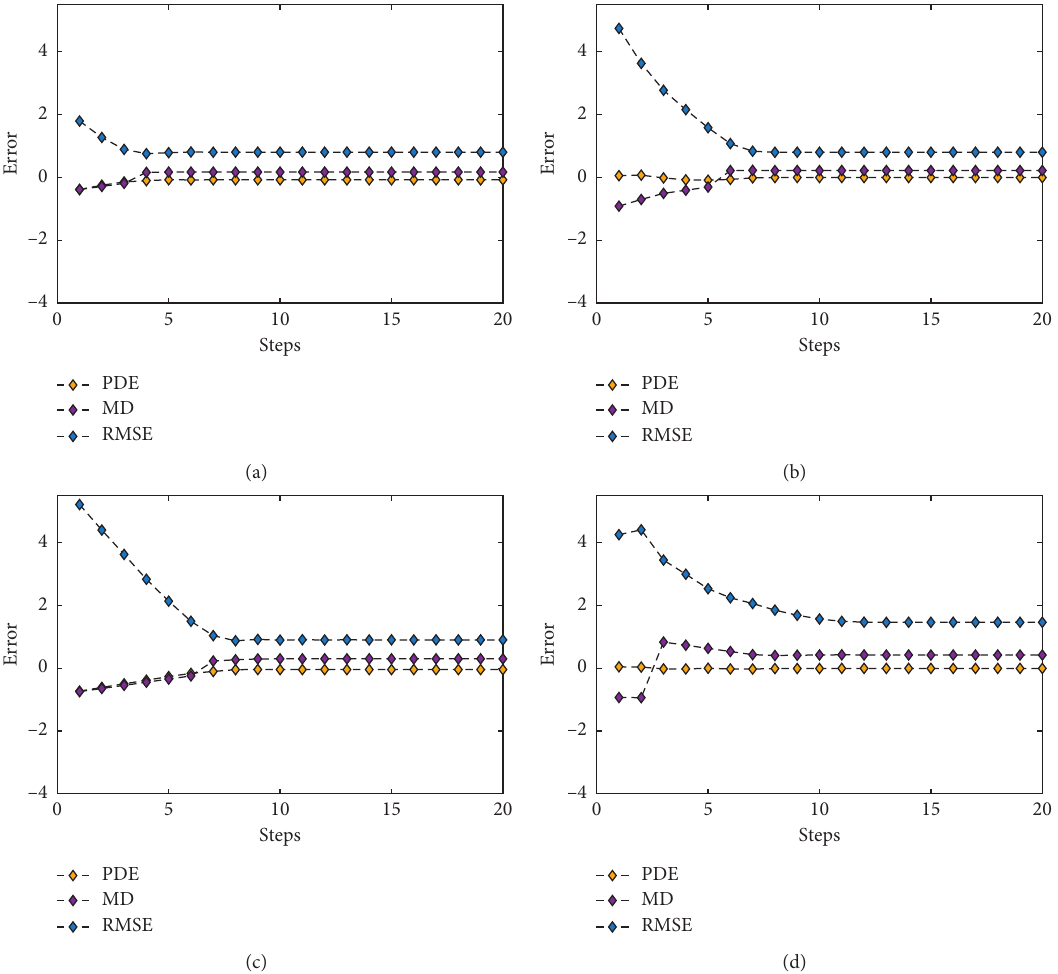
Figure 12: Error convergence for corresponding results in Figure 10. (a) 10% ranking. (b) 30% ranking. (c) 70% ranking. (d) 90%